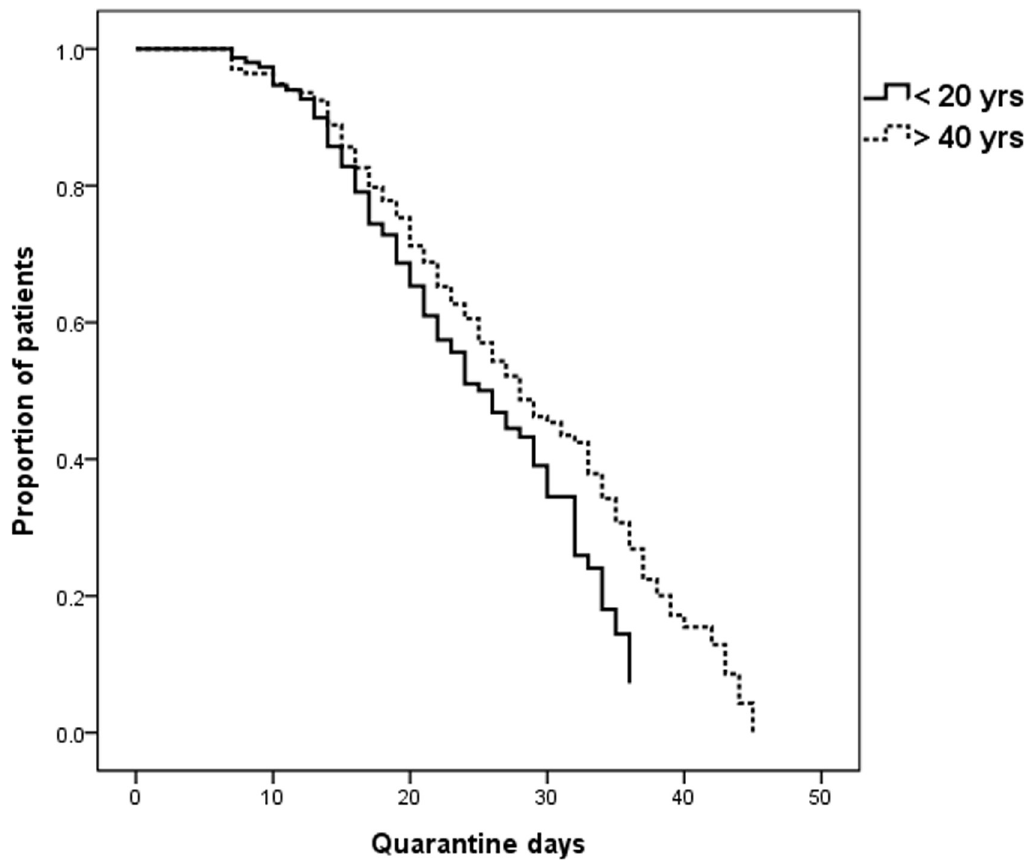
Fig 2. Quarantine time course of patients without negative conversion according to age ( p =